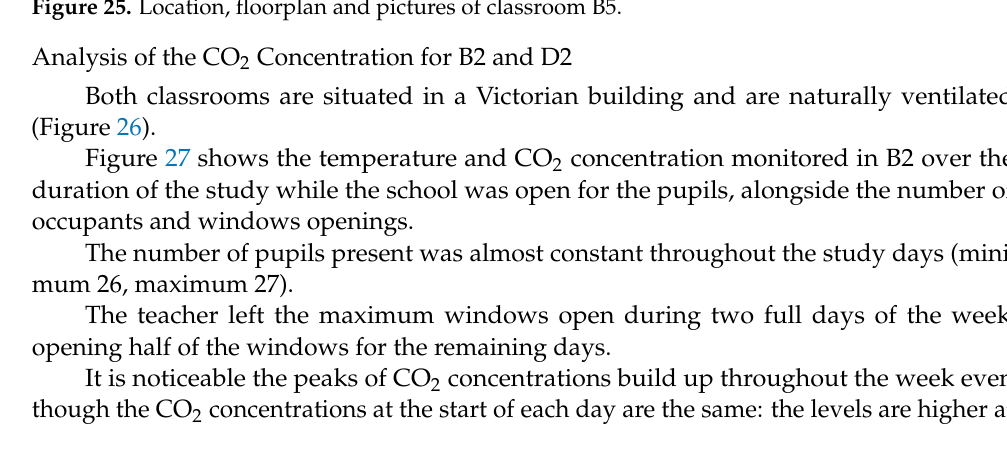
Figure 25. Location, floorplan and pictures of classroom B5.